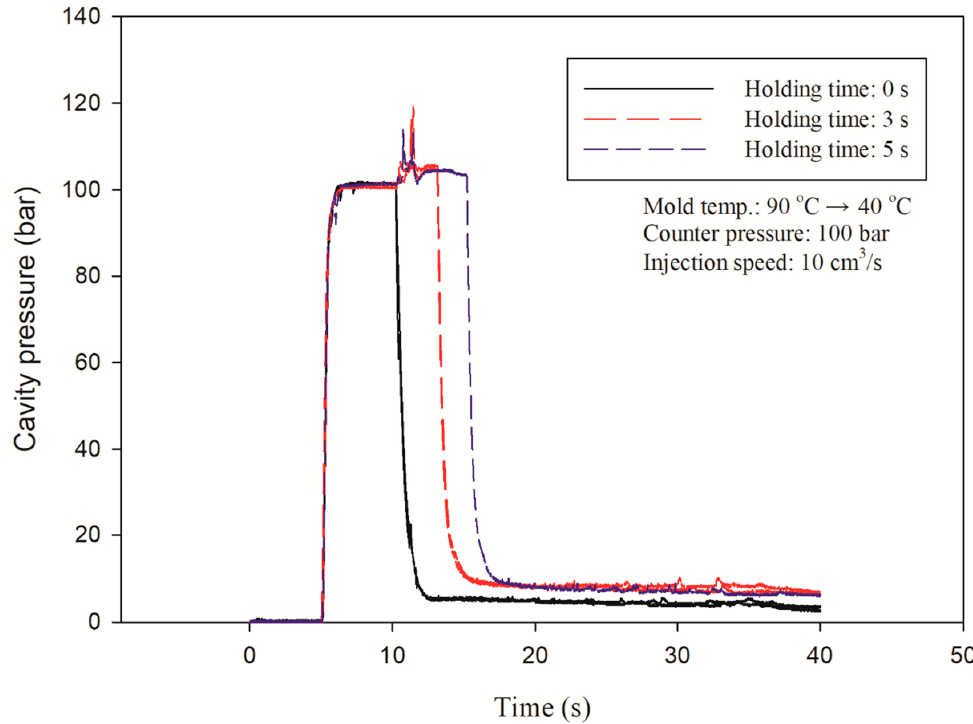
Figure 3. Cavity pressure traces under different holding times for GCP of 100 bar.